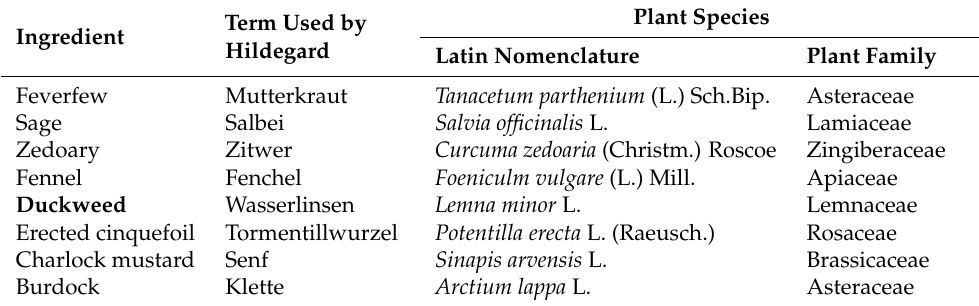
Table 1. Ingredients of the ointment against colic as recommended by Hildegard von Bingen.